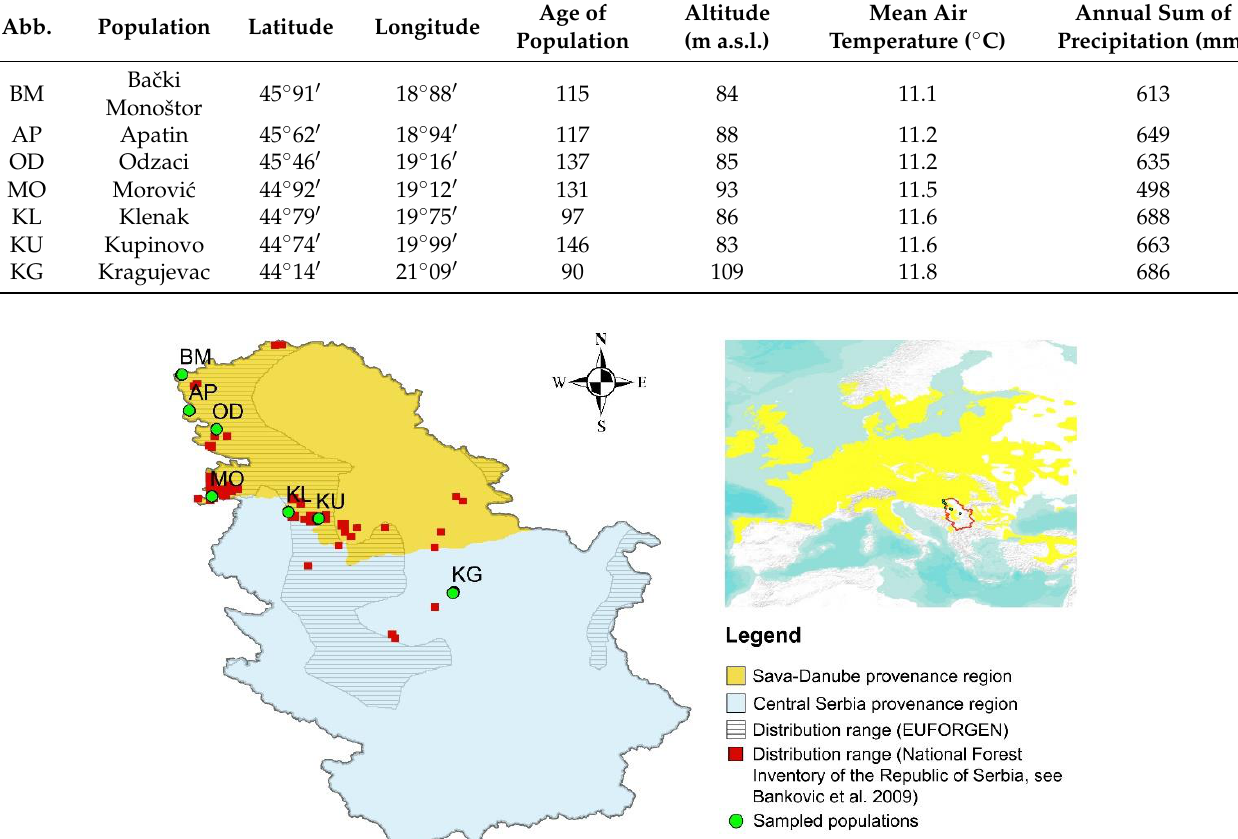
Table 2. Analyzed loci of pedunculate oak populations, sequences of microsatellite primers, repeated motifs, fragment length (bp), and specific primer annealing temperatures (Ta).